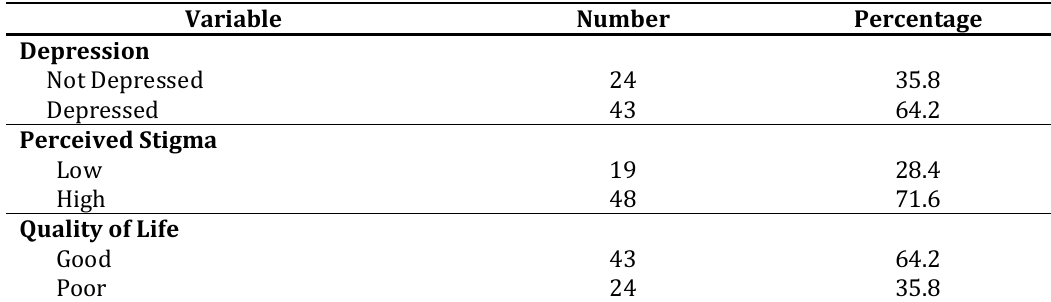
Frequency distribution according to the occurence of depression, stigma, and quality of life